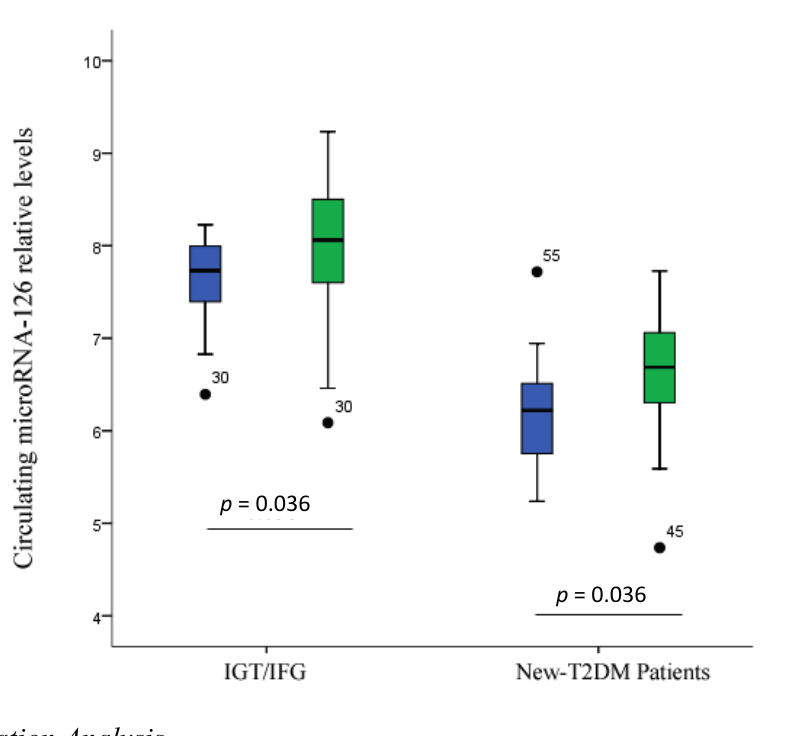
Figure 2. Changes in miR-126 levels after six months of treatment. Circulating miR-126 levels in IGT/IFG, new-T2DM patients before and after treatment. Data are shown as median (interquartile range).